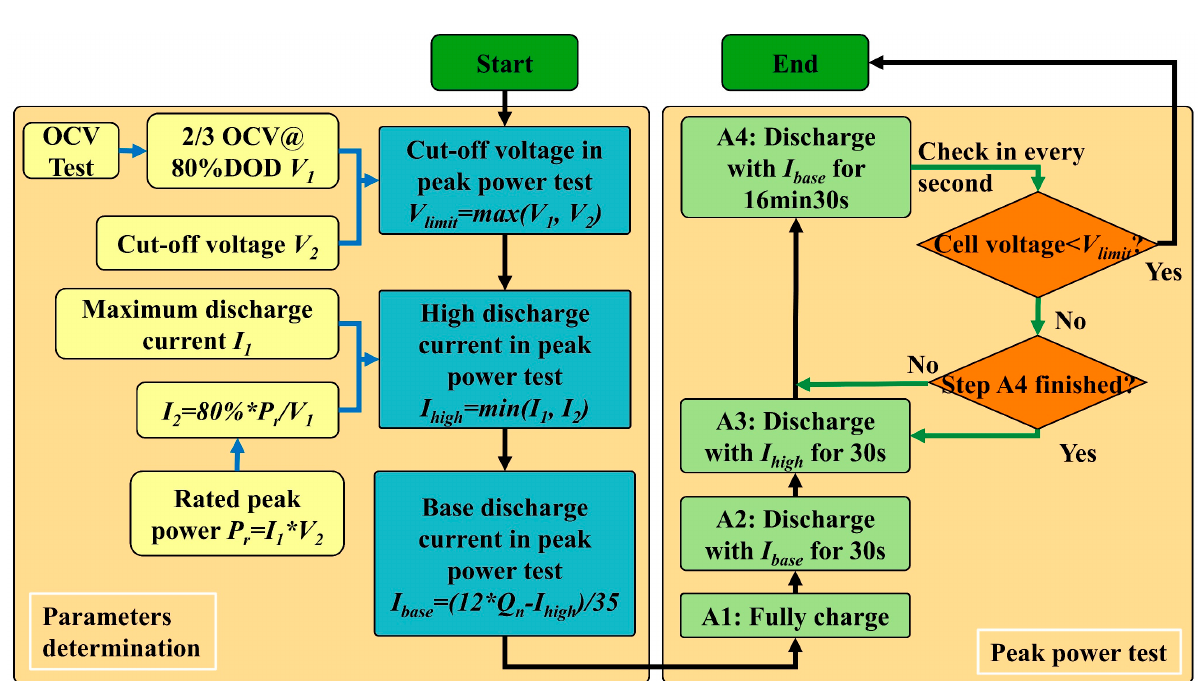
Figure 1. Schematic diagram of the peak power test.